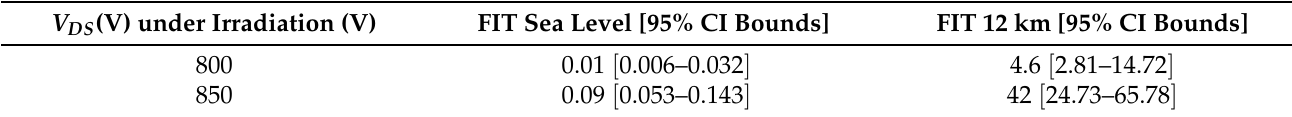
Table 1. The FIT values of the GEN3 SiC MOSFET tested by Airbus.